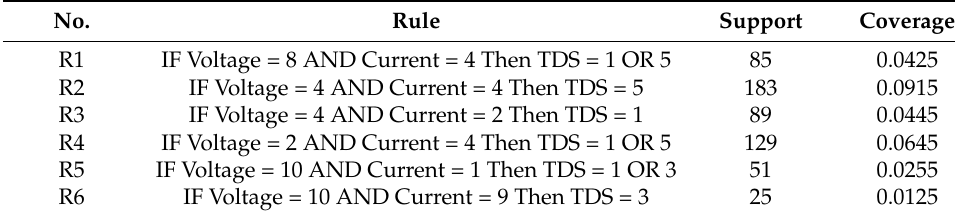
Table 7. Sample of results of Relay#8’s rules.